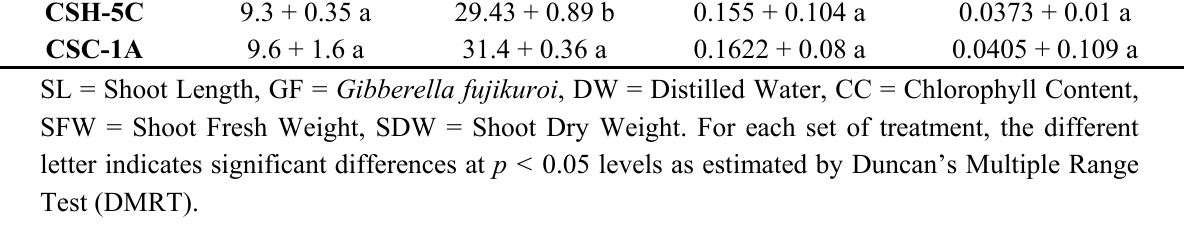
Table1. Effect of culture filtrate of isolated endophytic fungal strains on the growth of Waito-C rice. Strain SL (cm) CC (SPAD) Control (GF) CSH-5C SL = Shoot Length, GF = Gibberella fujikuroi , DW = Distilled Water, CC = Chlorophyll